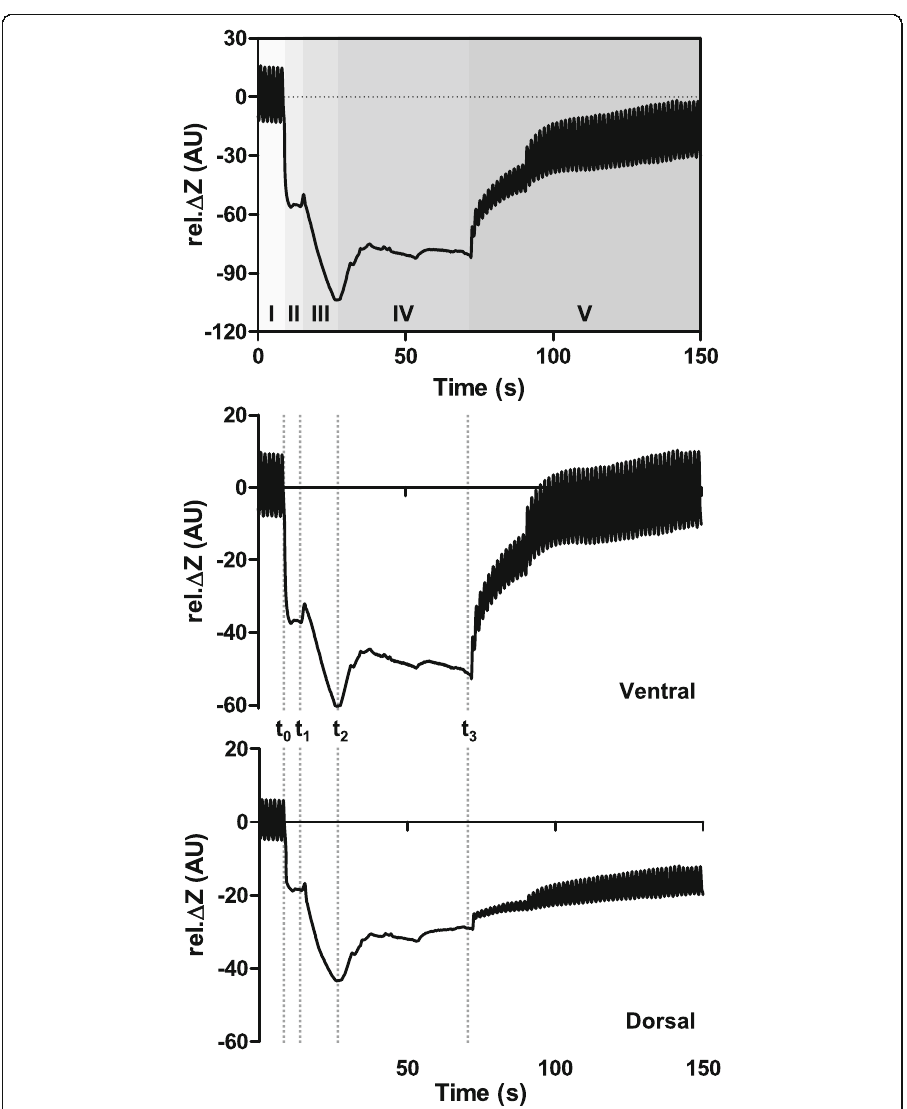
Fig. 1 Global and regional EIT waveforms with highlighted measurement phases before, during and after bronchoalveolar lavage. The global waveform shows the sum of all image pixel values of relative impedance changes (rel. Δ Z ) in arbitrary units (AU) (top), the regional ones in the ventral (middle) and dorsal image sections (bottom). The recording continued through five phases: I, continuous mechanical ventilation; II, disconnection of the endotracheal tube from the ventilator; III, administration of the lavage fluid through the endotracheal tube; IV, fluid recovery by suction, V, re-connection of the endotracheal tube to the ventilator and resumption of mechanical ventilation. (The small dent in the waveforms after approximately 60% of the suction phase IV (i.e. at 52s of the recording) was associated with the temporary evacuation of the fluid from the suction syringe. The clearly discernible change in the waveforms with higher tidal variation amplitude and increased end-expiratory values after the resumption of ventilation in phase V at time point 89 s resulted from the adjustment in ventilator settings with higher PEEP.) EIT data was analysed at three standardised time points: t 1 , after disconnection from the ventilator directly prior to the fluid instillation into the lungs; t t 2 , at the end of fluid instillation and 3 , at the end of suction of the lavage fluid immediately before the resumption of mechanical ventilation, in each case compared with bioimpedance at baseline phase I prior to the disconnection from the ventilator at t